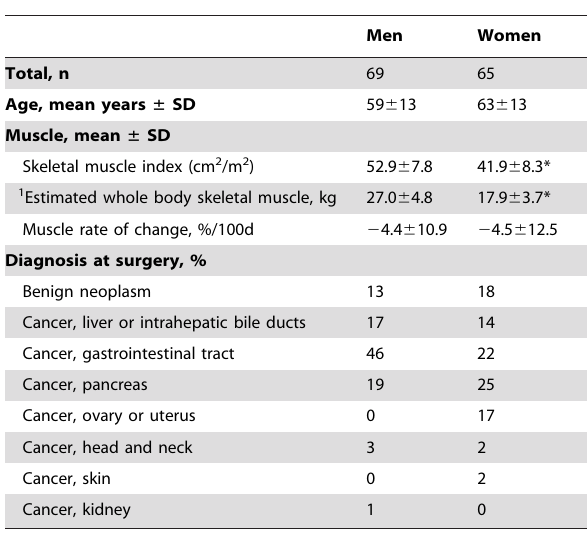
Table 1. Patient